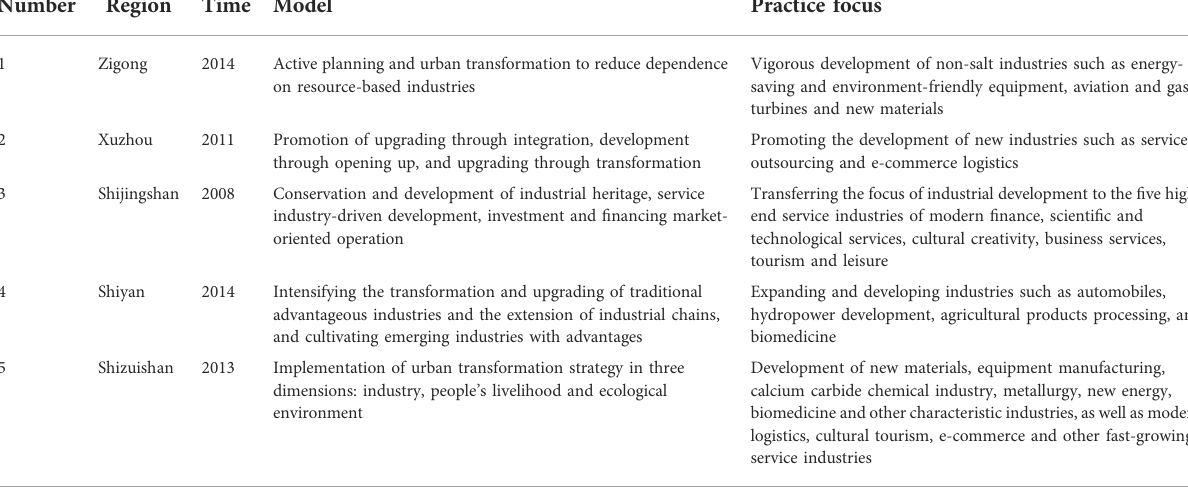
TABLE 1 Policy practices of relocation and reconstruction of old industrial bases (municipal districts).